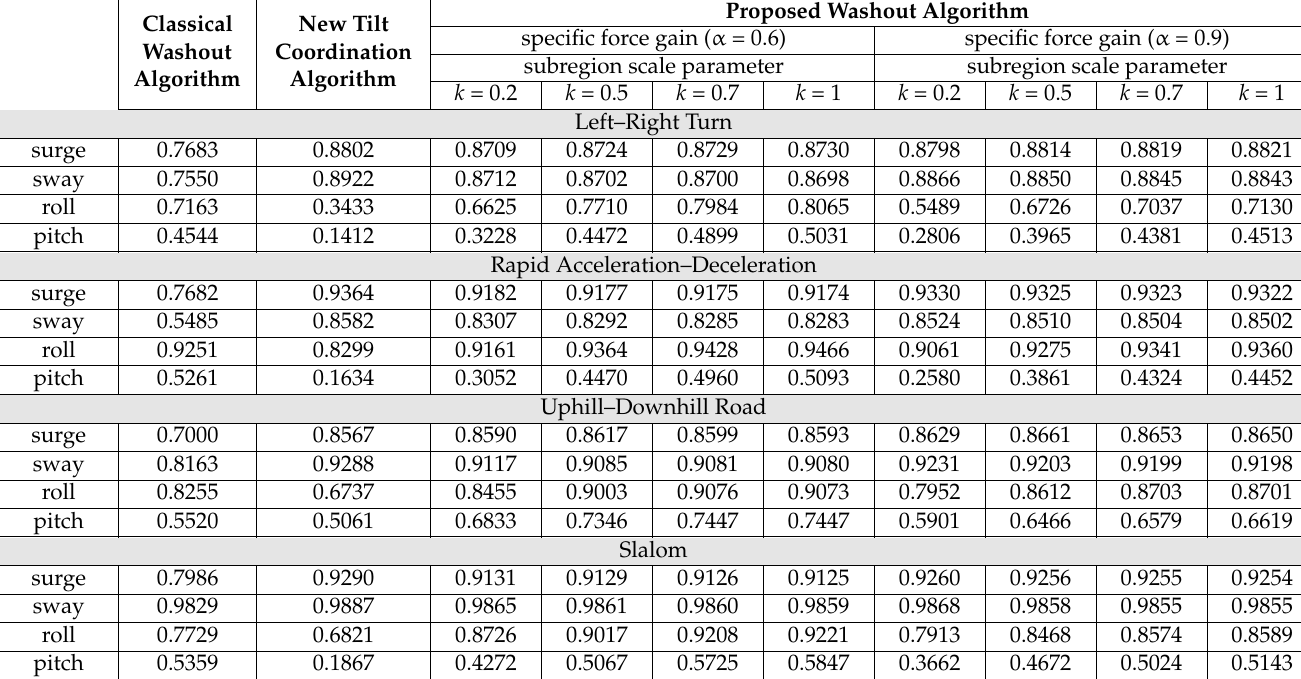
Figure 13. Simulation diagram for the motion sensation by the proposed washout algorithm. Table 4 represents correlation coefficient between the motion sensation of the actual Table 4. Correlation coefficient with motion sensation of the real vehicle and motion sensation of classical washout algorithm and proposed washout algo- rithm. The closer the correlation coefficient value is to one, the more similar it can be to the actual motion sensation.